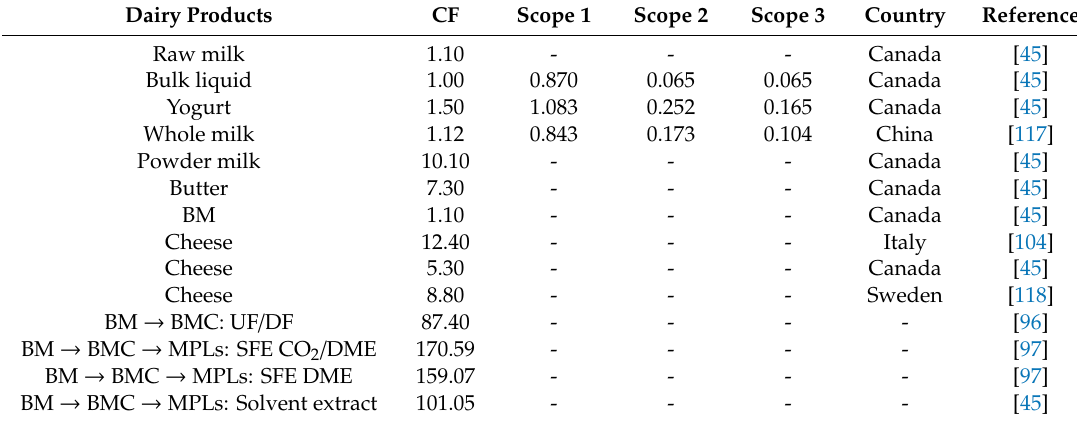
Table 5. Comparison of the carbon footprint of milk phospholipids in commercial dairy products (kg CO 2 / kg